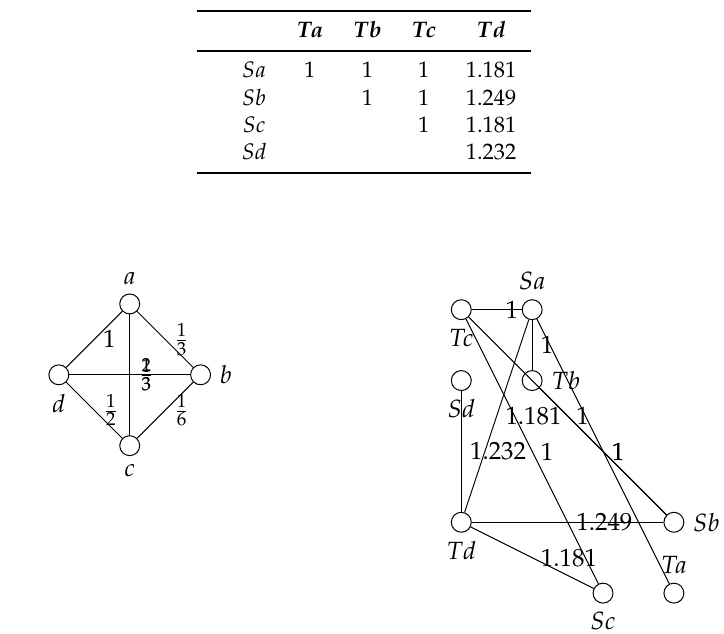
Figure 1. A graph indicated by distances and ξ -contractions of distances between the